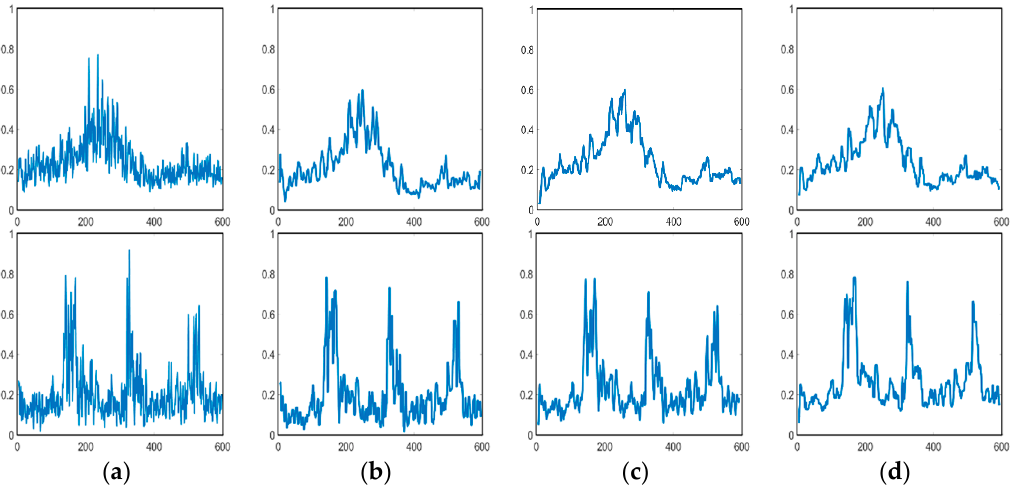
Figure 12. Example sand wave profile waveform and denoising. ( a ) Raw echo intensity sub-sequence. ( b ) Median filtering. ( c ) Gaussian filtering. ( d ) EEMD denoising.